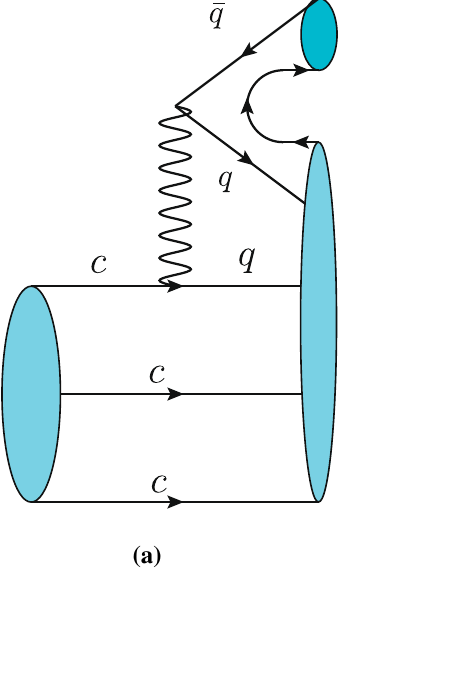
Fig. 3 Two typical